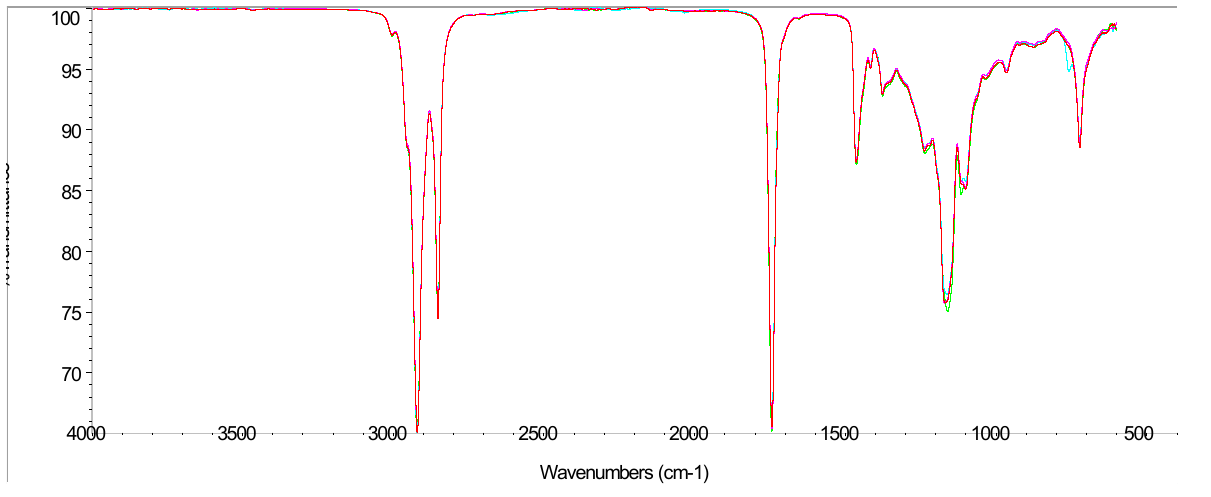
Figure 2: The residual error of PCA model for determination of optimum principle components used in PCA model.